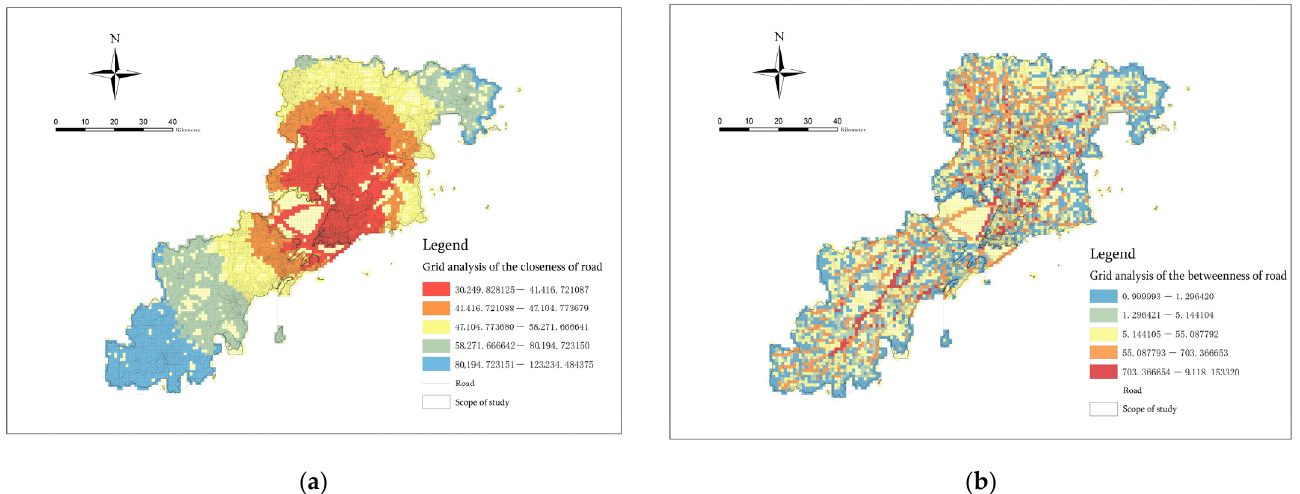
Figure 8. ( a ) The Closeness index of road and ( b ) the Betweenness index of road.